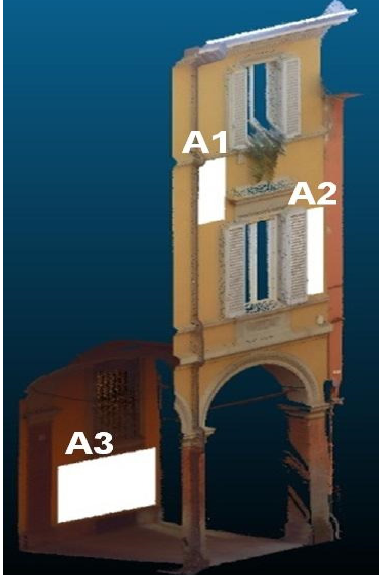
Figure 12. The three regions of interest (A1–A3) surveyed with TLS as ground truth.